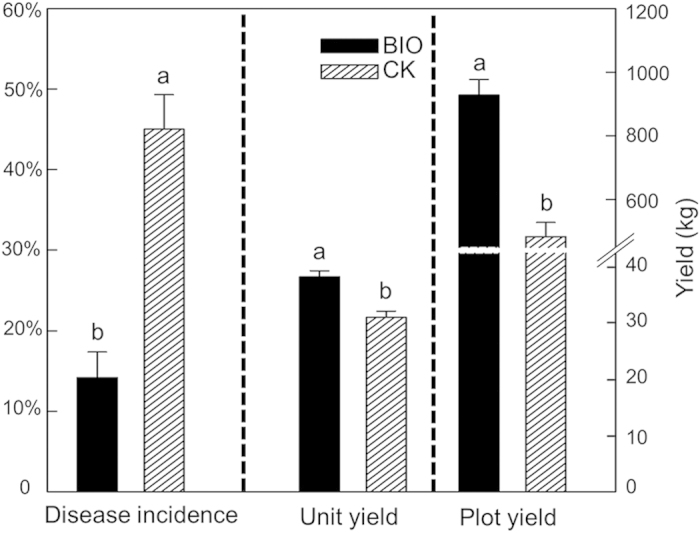
Yield and disease incidence of the bioorganic fertilizer (BIO) and control (CK) treatments.The significance of the difference was determined by two-way unpaired t-tests. Bars sharing the same character represent the lack of a significant difference (p > 0.05).